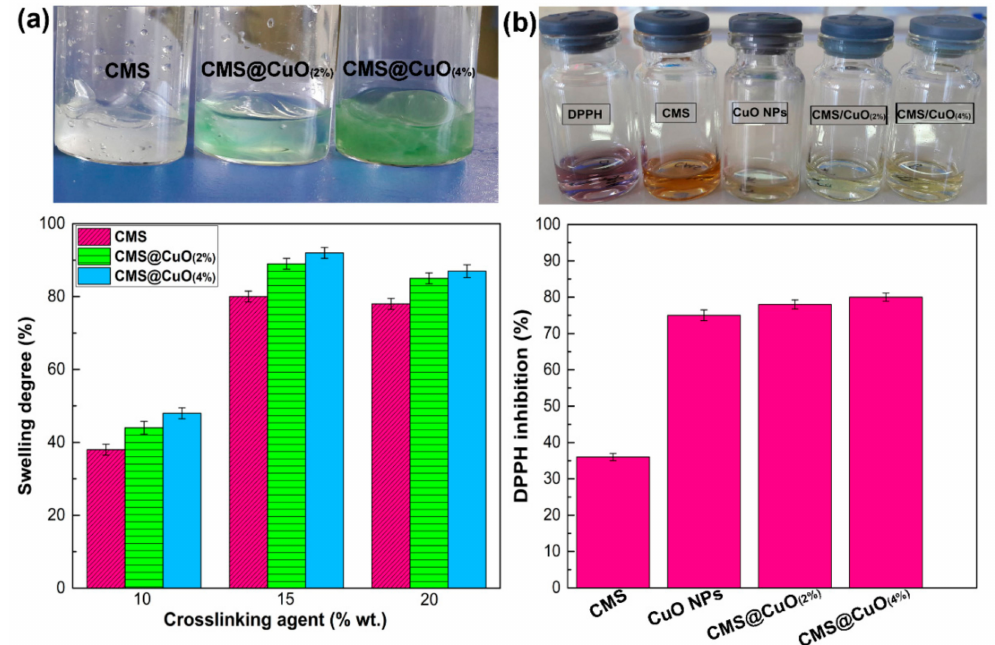
Figure 4. Histograms and photographs depicting the swelling behavior of the CMS hydrogel and the CMS@CuO nanocom- posite hydrogels containing 2 wt.% and 4 wt.% CuO nanoparticles. The histogram on the left shows swelling in the presence of different concentrations of citric acid as crosslinking agent ( a ). The histogram on the right and the photograph above show the antioxidant activity of CMS, CuO nanoparticles and the CMS@CuO nanocomposite hydrogels with 2 wt.% and 4 wt.% CuO nanoparticles ( b